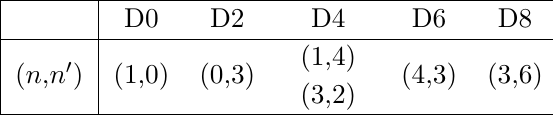
1/2-BPS D-branes in the AdS 4 (cid:2) CP 3 background. n ( n 0 ) represents the number